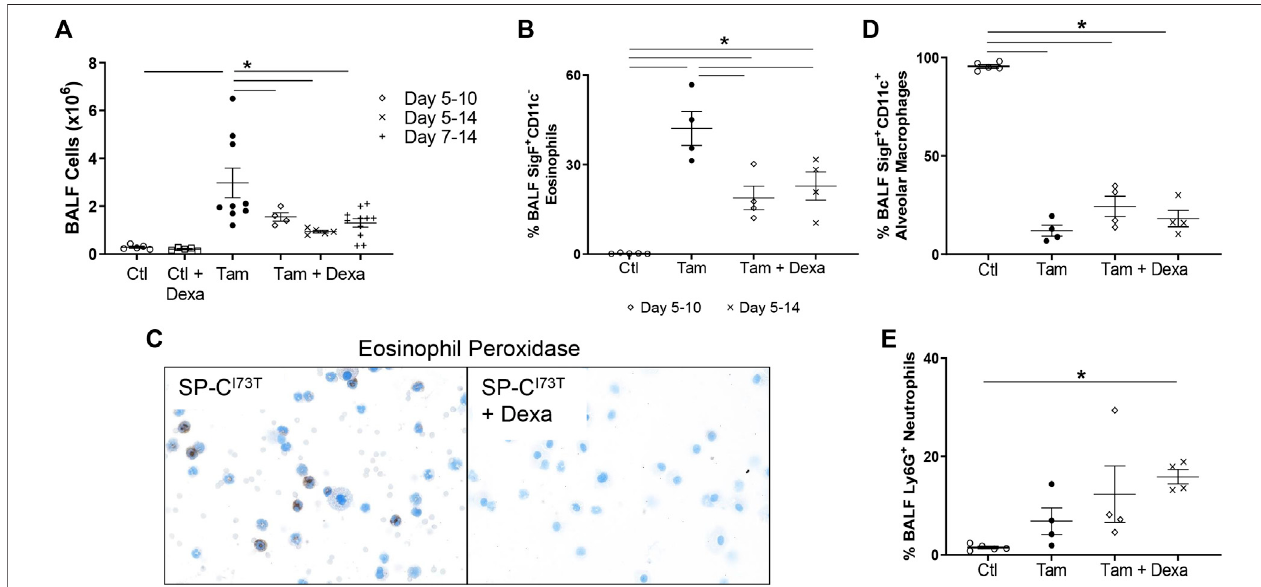
FIGURE 8 | In fl ammatory cell changes in dexamethasone treated mice during SP-C I73T induced injury. (A) Bronchoalveolar lavage fl uid (BAL) cell counts from control (CTL, oil and dexamethasone treated SP-C I73T mice) or SP-C I73T mice 14 days post SP-C I73T induced injury. Three dexamethasone groups are described (1 mg/kg), receiving daily i.p. injections between day 5 – 10, 5 – 14, or 7 – 14 following tamoxifen induction. Controls + dexamethasone group received ten daily injections (equivalenttothelengthiestdexamethasoneadministration).Dataarepresentedasmean±SEM( n =4 – 9mice/group),analyzedusingtwo-wayANOVA.A p < 0.05 (*) was considered signi fi cant. Lines mark signi fi cant groups. (B) Flow cytometric analysis of BAL CD11b + CD11c − SigF + eosinophils from control (Ctl, oil or dexamethasone treated SP-C I73T mice), tamoxifen treated, or tamoxifen + dexamethasone treated SP-C I73T mice 14 days after injury. Two dexamethasone groups are described (1 mg/kg), receiving daily i.p. injections between day 5 – 10 or 5 – 14 following tamoxifen induction. Data presented as mean ± SEM ( n = 4 – 5 mice/group), analyzed using one-way ANOVA. A p < 0.05 (*) was considered signi fi cant. (C) Eosinophil Peroxidase staining of BAL cytospins prepared 14 days after tamoxifen (left panel) or tamoxifen + dexamethasone (right panel) treatment. (D,E) Flow cytometric analysis of BAL (D) CD11b − CD11c + SigF + alveolar macrophages and (E) Ly6G + neutrophilsfromcontrol(Ctl,oilordexamethasonetreatedSP-C I73T mice),tamoxifen treated,ortamoxifen+dexamethasonetreatedSP-C I73T mice14 days